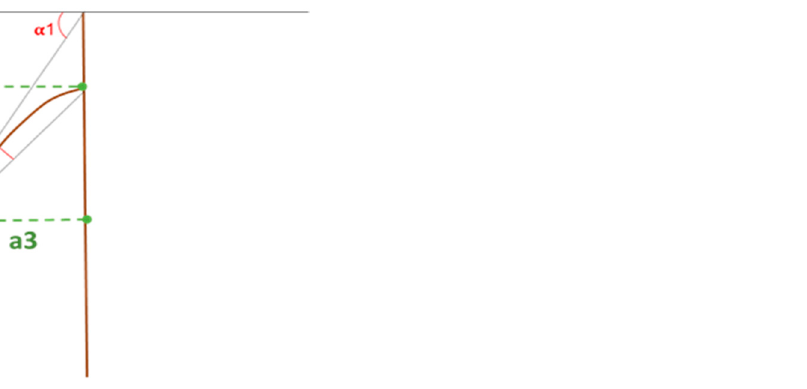
Figure 2. A diagrammatic representation of root angle measurement of soybean cultivars 10 days after sowing. ( α 1) is the angle between the longest lateral root and the horizontal line of soil, and ( α 2) is the angle between the longest lateral root and the horizontal line from the point of insertion of this root on the taproot.